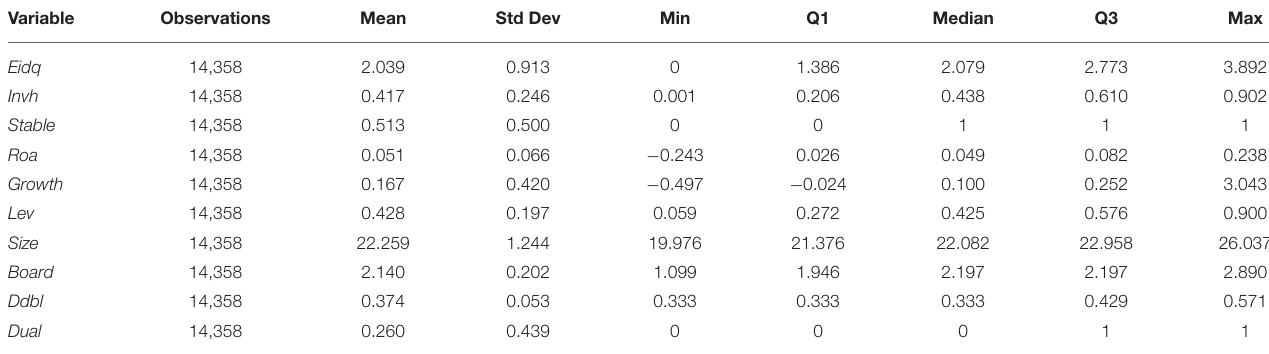
TABLE 3 | Descriptive statistics of the main variables.